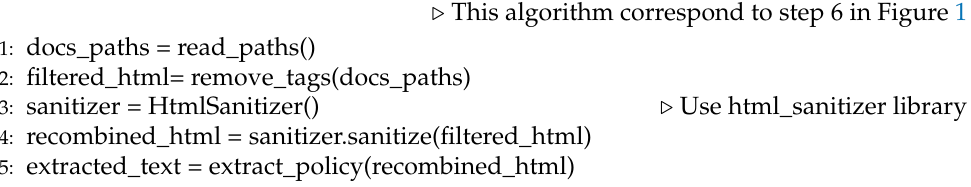
Algorithm 2 Common algorithm of privacy policies